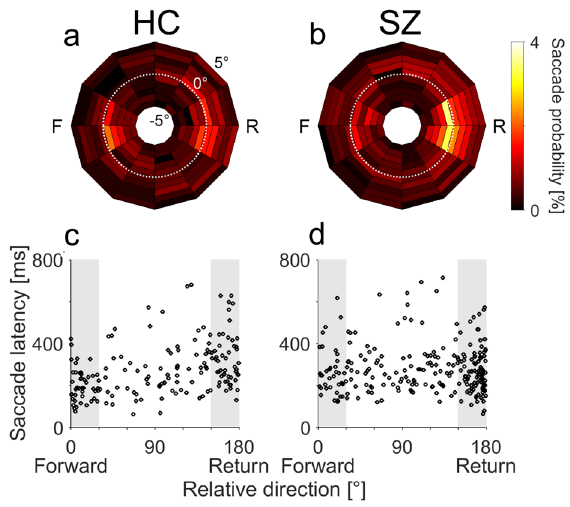
Figure 2. ( a , b ) The distributions of the amplitudes and directions of individual saccades relative to their respective one-back saccades for a representative HC ( a ) and SZ ( b ). Probabilities of saccades with different directions (denoted by the angles of the polar plots; 30° bins) and amplitudes (denoted by the radius; 1° bins, range − 5° to 5°) relative to the preceding saccades are shown as heatmaps. White dotted lines represent an amplitude difference of 0°, indicating that a saccade has the same amplitude as the preceding saccade. F and R indicate forward and return directions, respectively. ( a ) The HC made both return and forward saccades more frequently than saccades in other directions. ( b ) The SZ exhibited more return saccades than forward saccades. ( c , d ) The saccade latencies are plotted against the relative saccade directions for amplitude-matched (< 1°) sequential saccades for the same HC ( c ) and SZ ( d ). Data within the shaded areas are defined as forward (left) and return (right)